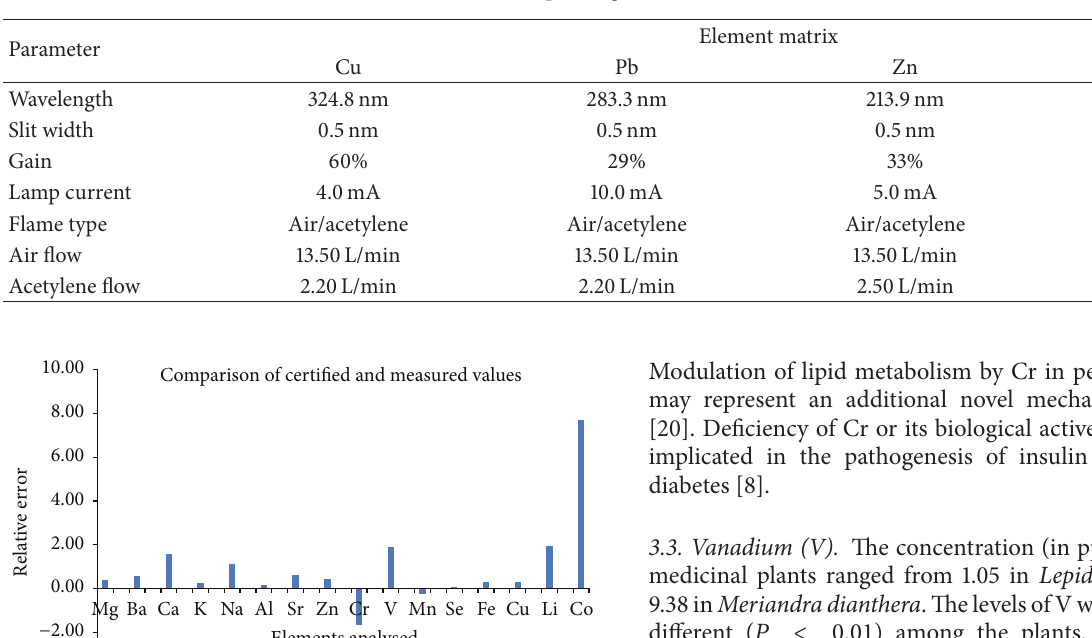
Table 2: The operating conditions of the FAAS.